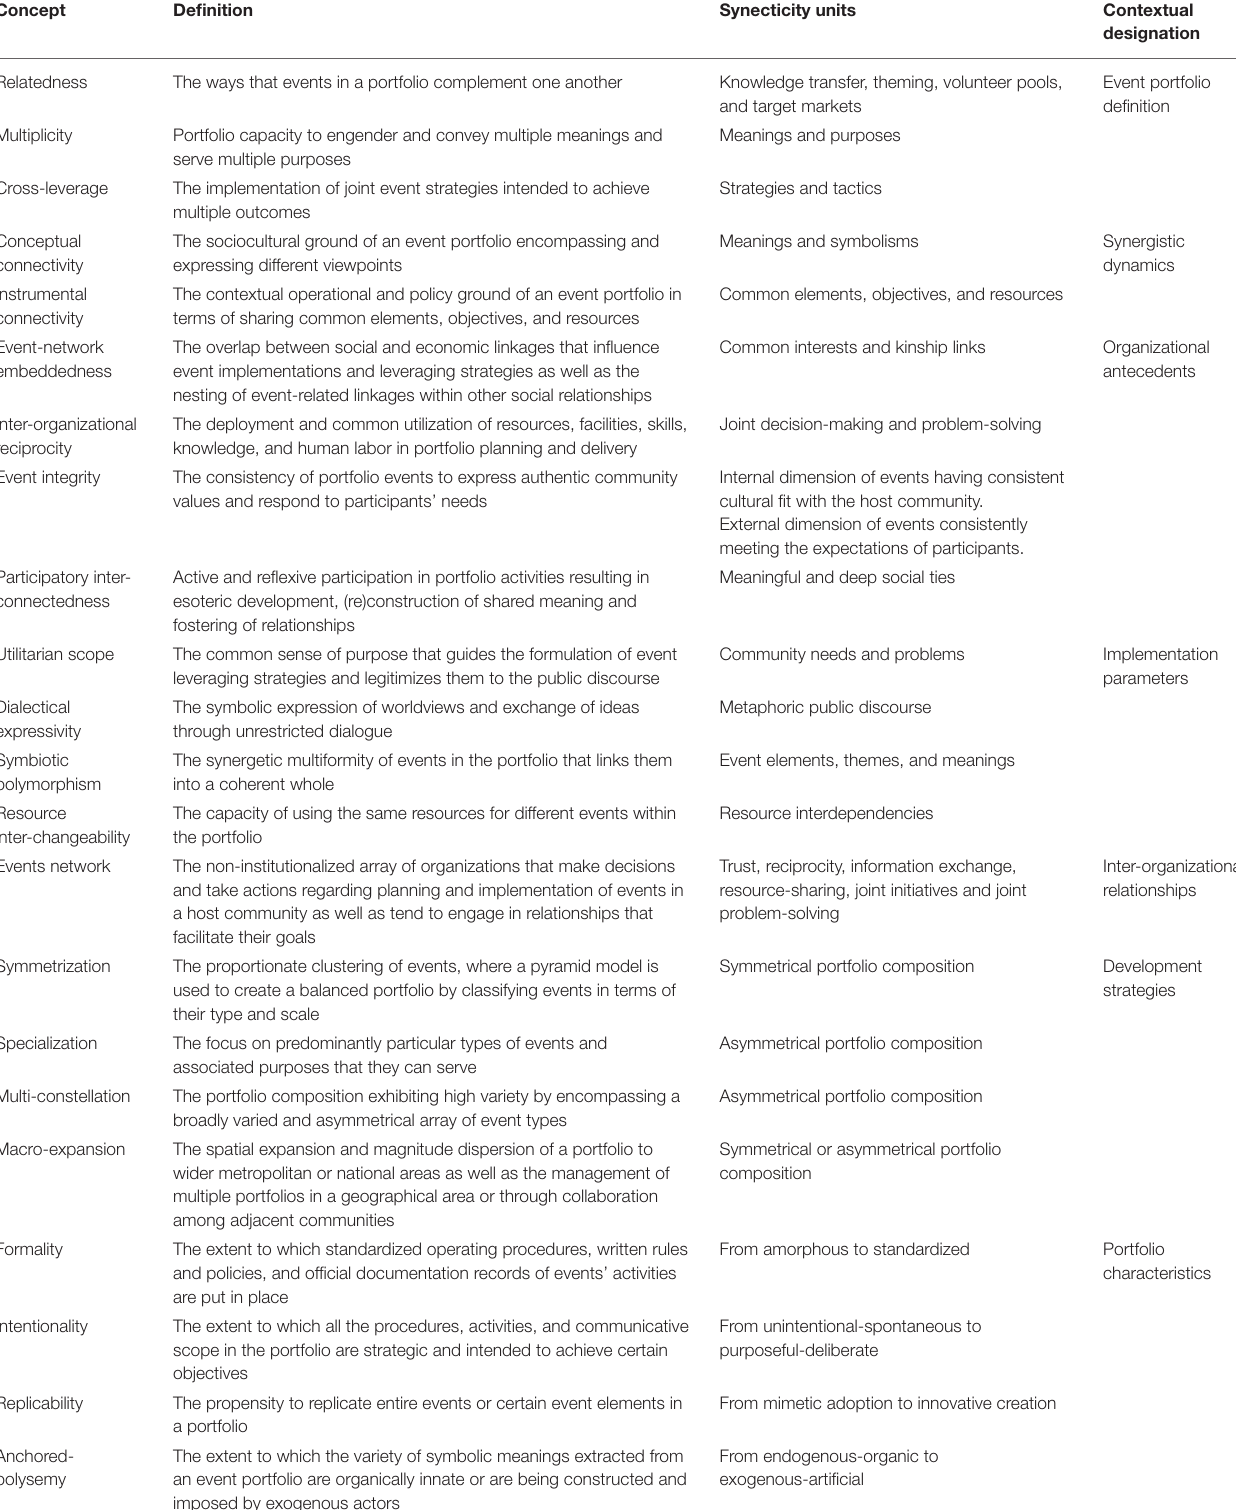
TABLE 1 | Lexicon of relational synecticity and morphosynthesis of event